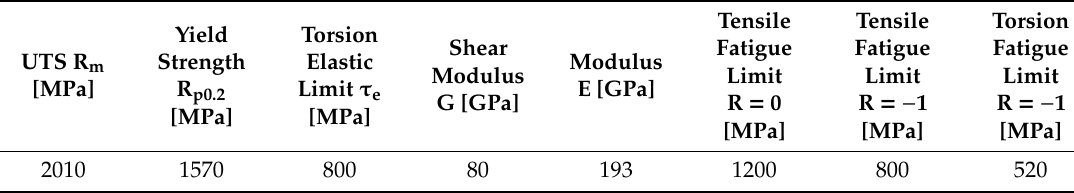
Table 1. Average mechanical properties of the torsion